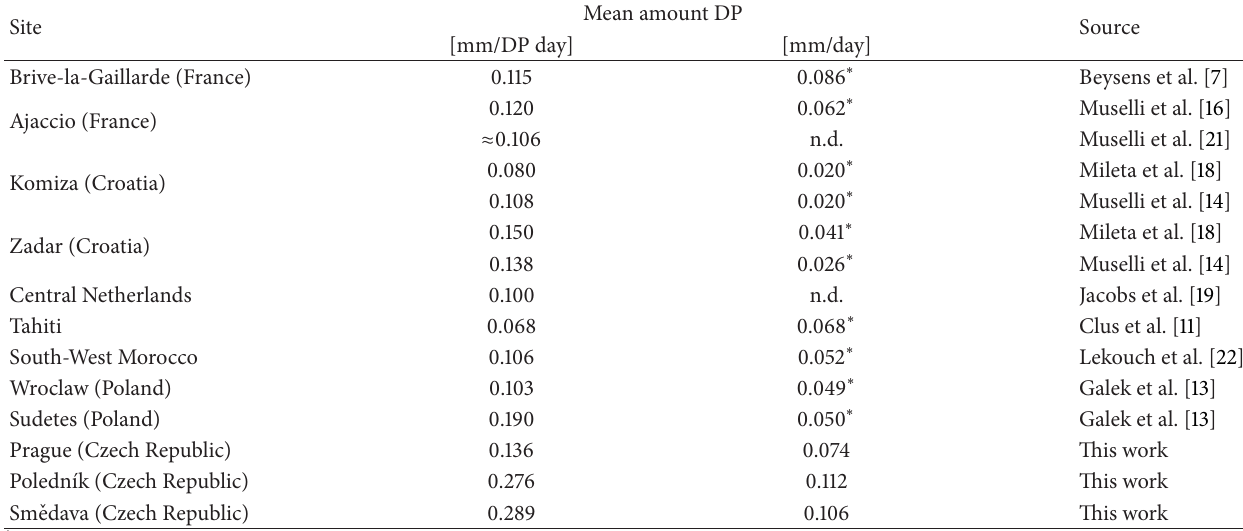
Table 3: Comparison of results of previous